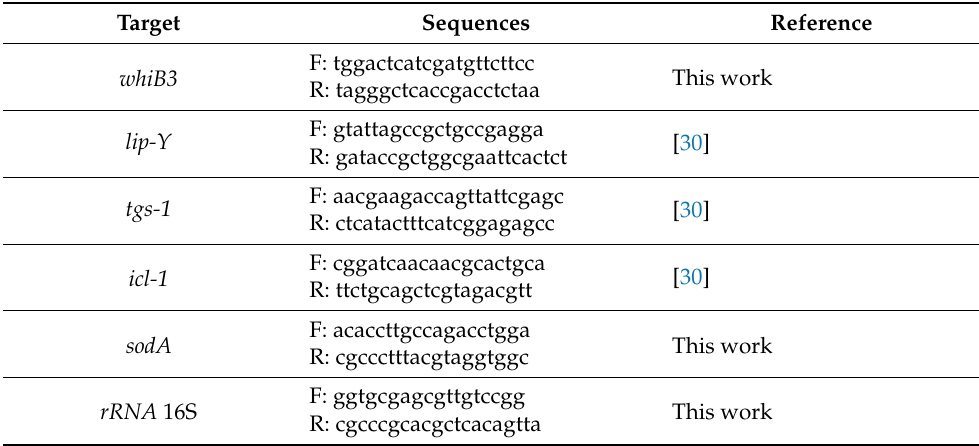
Table 1. Primers used for gene expression